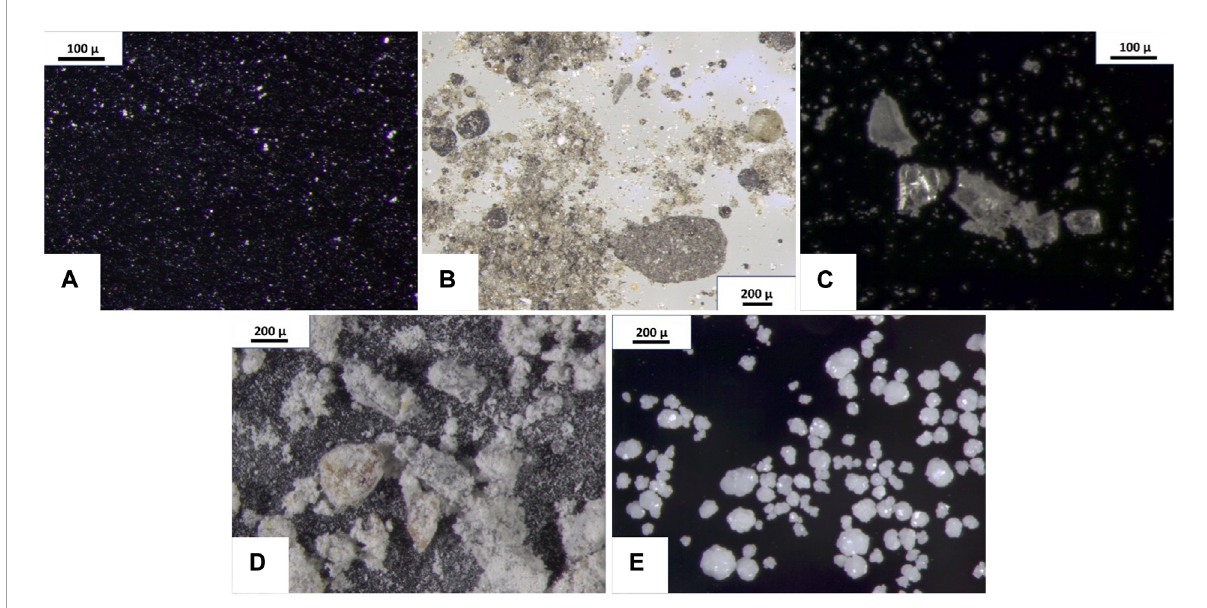
FIGURE 2 Microphotographs of the geopolymeric precursors: (A) volcanic tuff; (B) fly ash; (C) blast-furnace slag; (D) surrogate waste; (E) aluminium oxide.